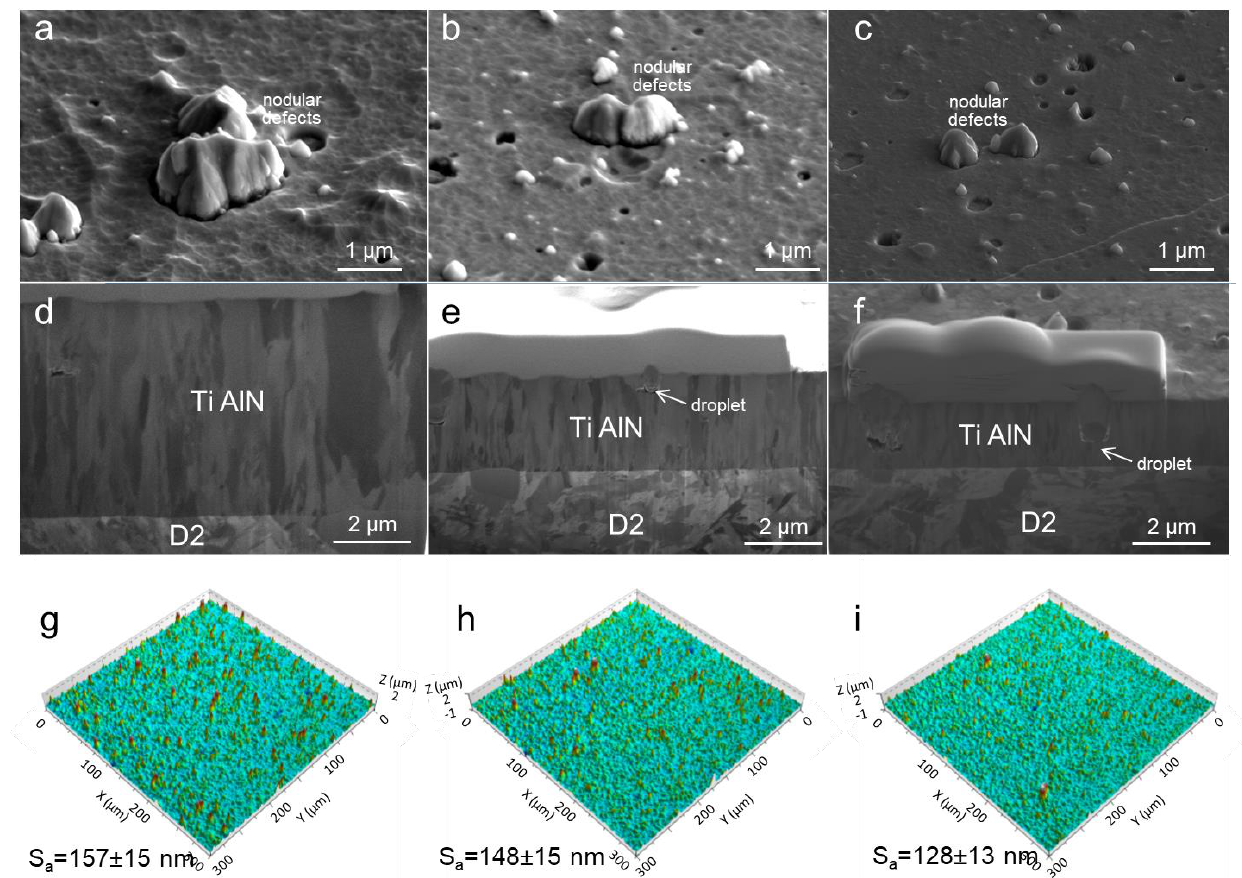
Figure 28. Top-view SEM images ( a – c ), SEM images of FIB cross-section ( d – e ) and 3D surface profile images ( g – i ) of TiAlN hard coatings deposited on D2 tool steel substrate in the AIP deposition system using 1-fold ( a , d , g ), 2-fold ( b , e , h ) and 3-fold rotation ( c , f , i ). The magnification scales are identical. The top SEM images were recorded from the side view at about 45° direction.